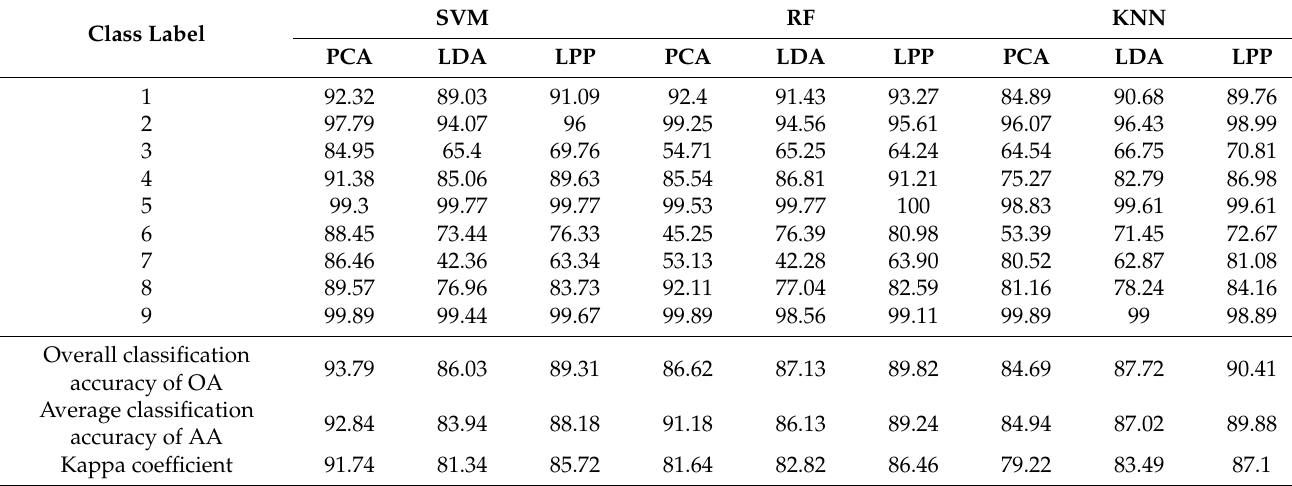
Table 3. Classification accuracy of Pavia University data